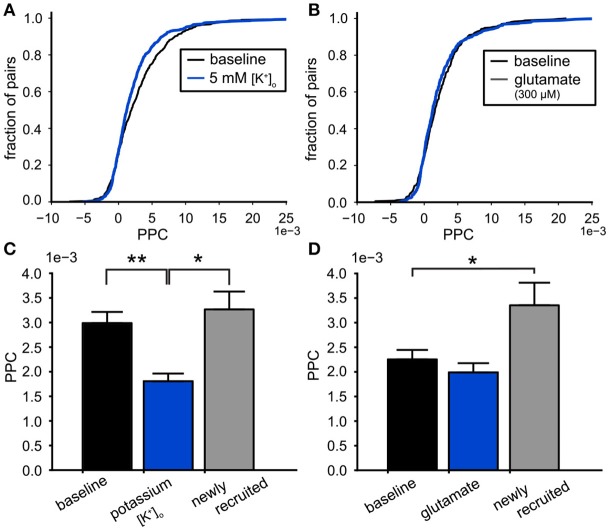
Effects on functional connectivity induced by high potassium and glutamate. (A) The cumulative PPC for the high potassium (5 mM [K+]o ) and baseline conditions. The leftward shift of the distribution shows that the pairwise connectivity was weakened during the high potassium condition (baseline: 442 pairs, high potassium: 652 pairs). (B) The cumulative PPC histograms for the baseline and 300 μM glutamate conditions. The two distributions were identical, indicating that the network strength was similar for both conditions (baseline: 367 pairs, glutamate: 486 pairs). (C) Comparison of the mean PPC for neuron pairs during baseline conditions (black bar, n = 415), with the same pairs during 5 mM [K+]o (blue bar, n = 415) and the connections made by neurons newly recruited by 5 mM [K+]o (gray bar, n = 237). The weakening of the functional connectivity by high potassium originated from the functional connections already present during baseline. (D) Comparison of the mean PPC for neuron pairs during baseline conditions (black bar, n = 349), with the same pairs during 300 μM glutamate administration (blue bar, n = 349) and the connections made by neurons newly recruited by 300 μM glutamate (gray bar, n = 137). The functional connections already present during baseline were not affected by glutamate (black), however the connections made by the recruited neurons were stronger than baseline (gray). *p < 0.05, **p < 0.01.